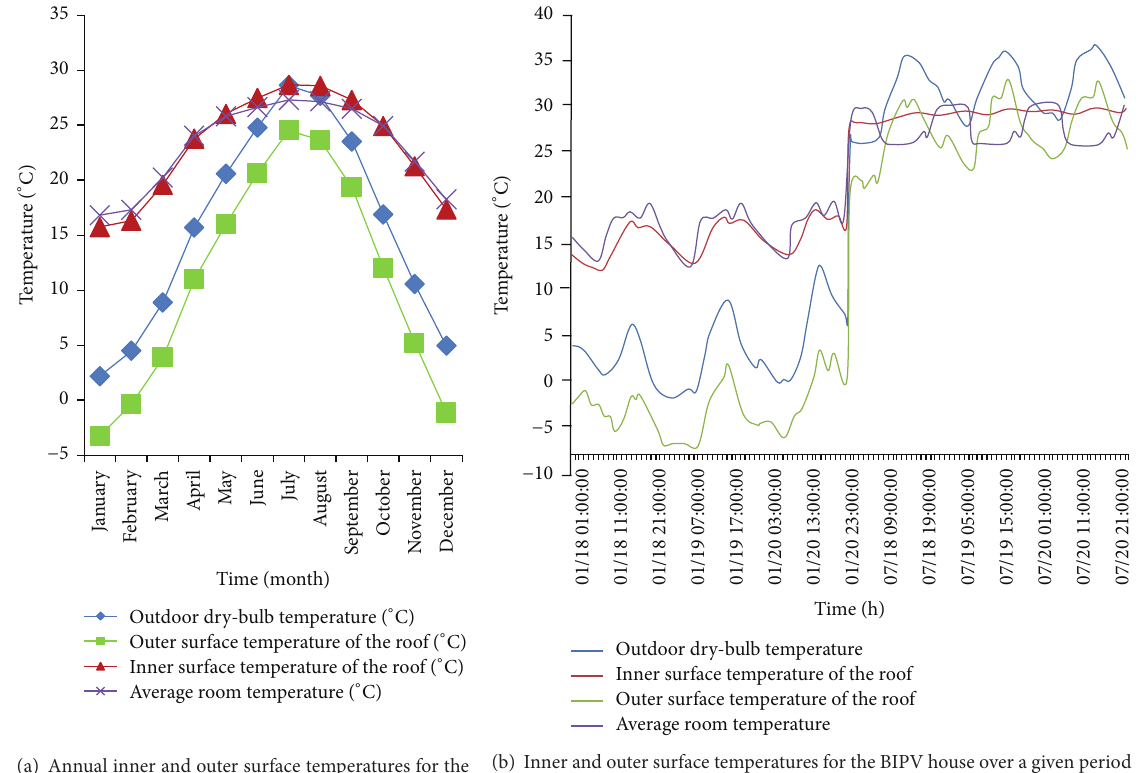
(b) Inner and outer surface temperatures for the BIPV house over a given period of time during the winter and summer Figure 9: Simulated inner and outer surface temperatures for the BIPV